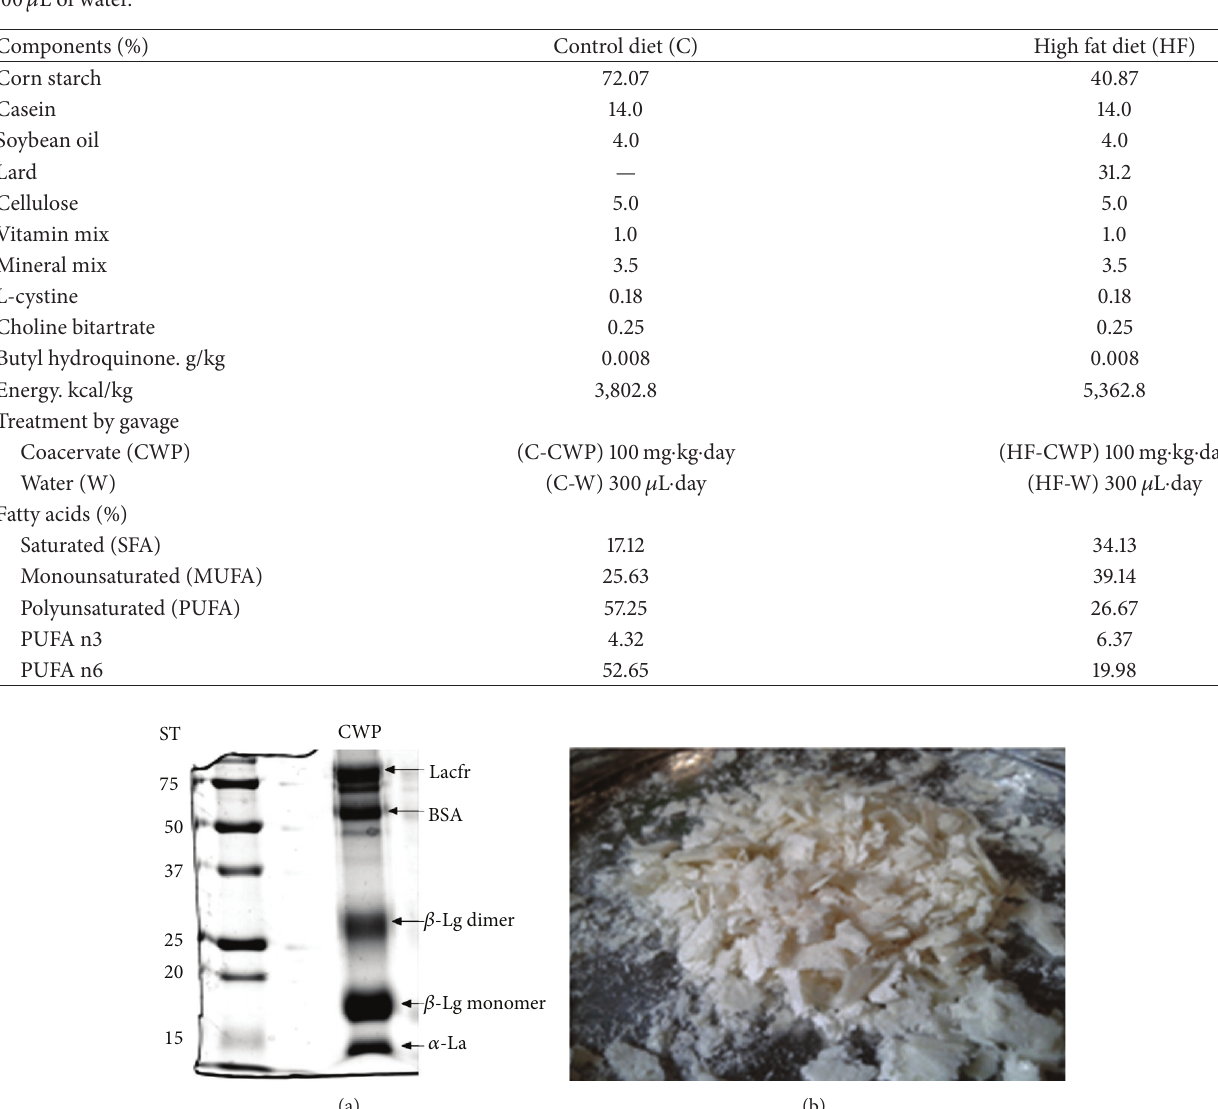
Figure 1: (a) Electrophoretic profile coacervate using 0.75 mg/ml of chitosan. ST: standard of different molecular weights, 𝛼 -La: alpha- lactalbumin (14kDa), 𝛽 -Lg: beta-lactoglobulin monomer (18kDa) and dimer (34kDa), BSA: bovine albumin (66kDa), and Lacfr: lactoferrin (86kDa). (b) Aspect of CWP proteins in Chitosan,